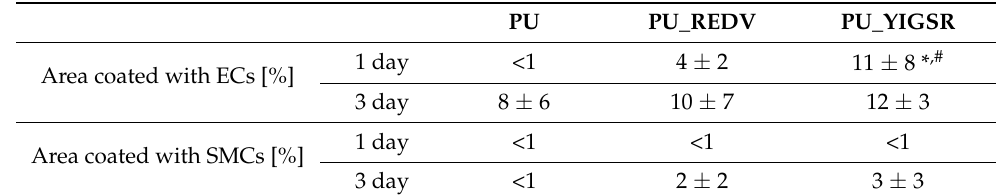
Table 2. Percent of the area occupied by EC and SMC.